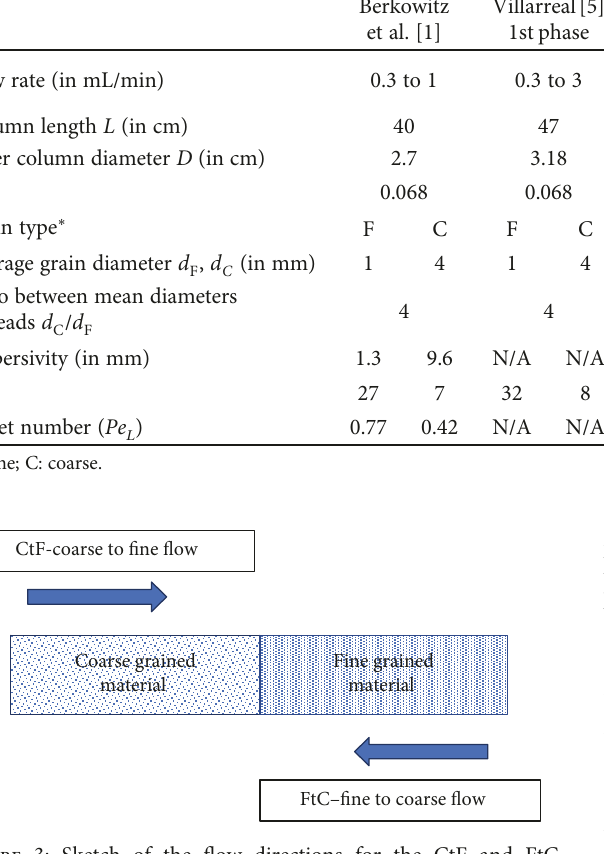
Figure 3: Sketch of the fl ow directions for the CtF and FtC